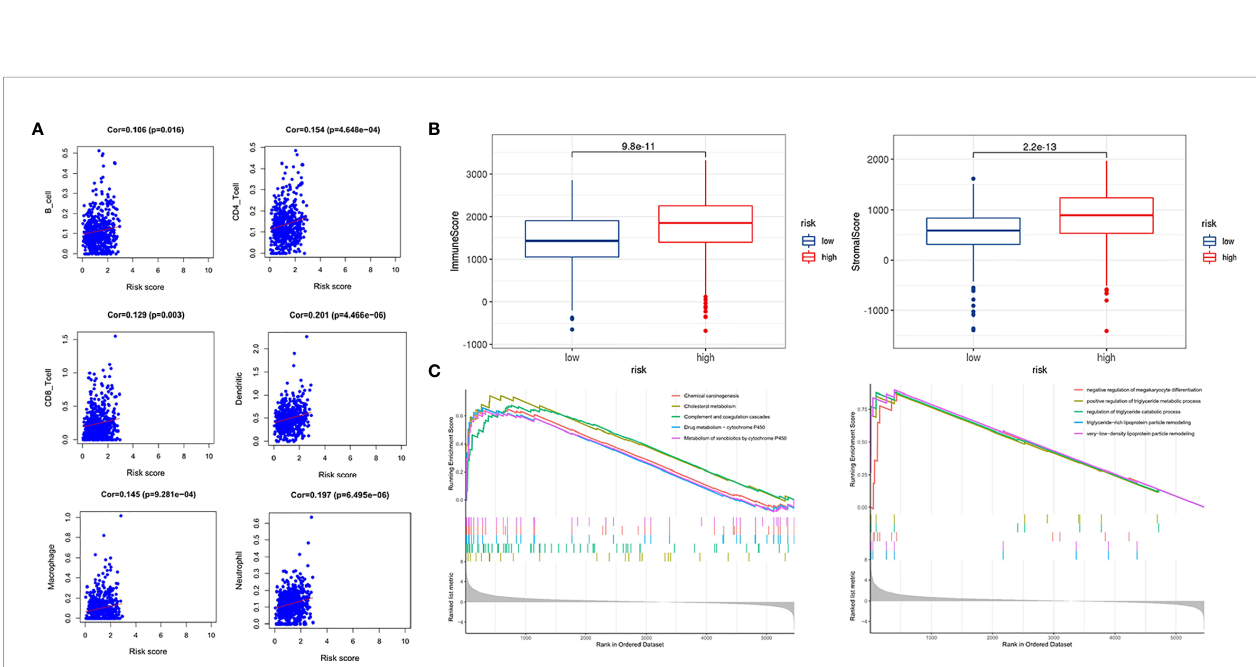
FIGURE 8 | Immune in fi ltration correlation analysis and GSEA. (A) Correlation between risk score and immune in fi ltration abundances in ccRCC of six immune cells obtained from TIMER (https://cistrome.shinyapps.io/timer/). (B) Relationships between risk score and immune score, and stromal score. (C) GSEA in TCGA KIRC dataset.